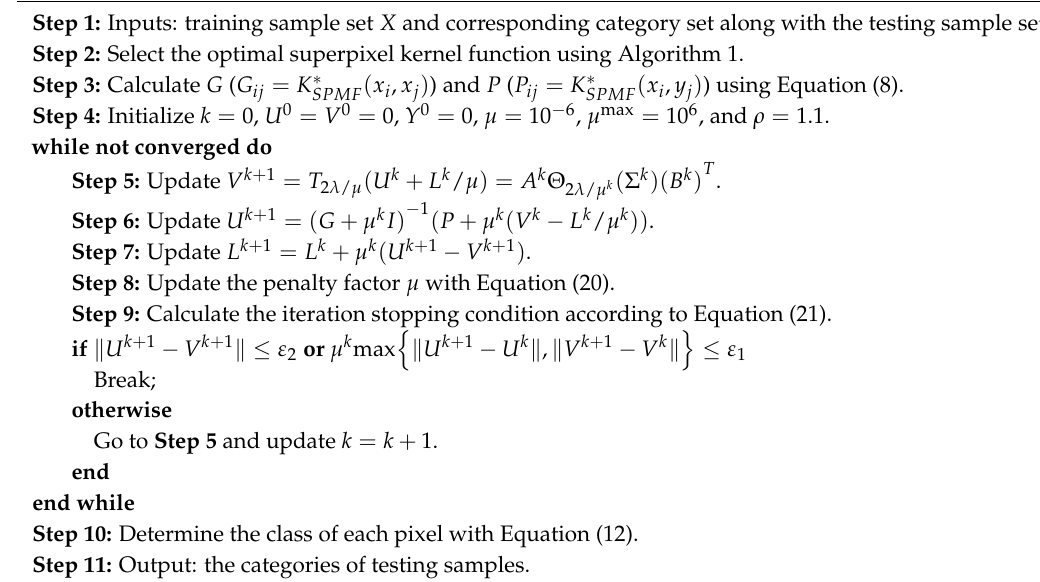
Algorithm 2. Superpixel kernel low rank representation-based classification